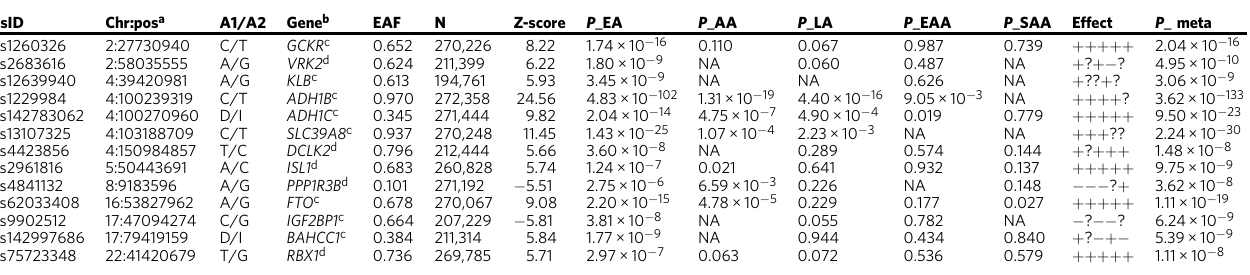
Table 1 Genome-wide signi fi cant associations for AUDIT-C in the trans-population meta-analysis rsID Chr:pos a